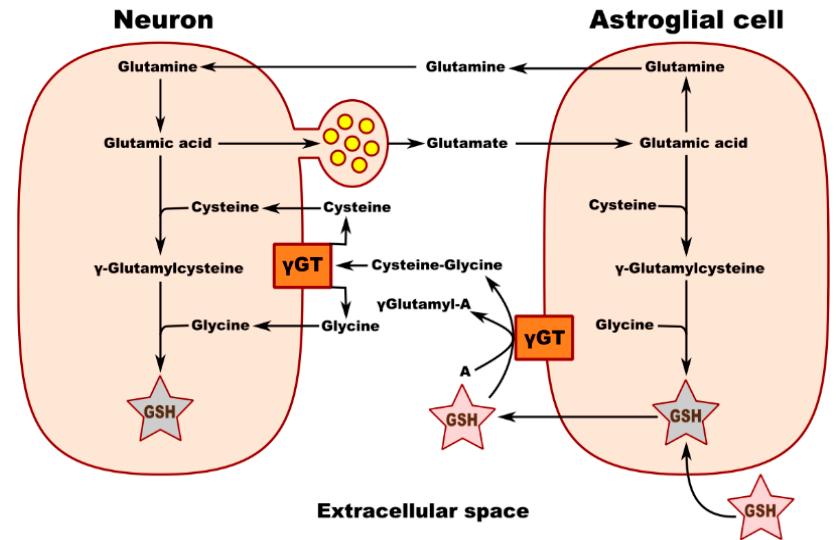
Figure 2. Schematic of neuronal GSH transport and metabolic interaction between neurons and as- troglial cells. γ GT—gamma-glutamyl transpeptidase; A—acceptor of g-glutamyl moiety transferred from GSH by γ GT.